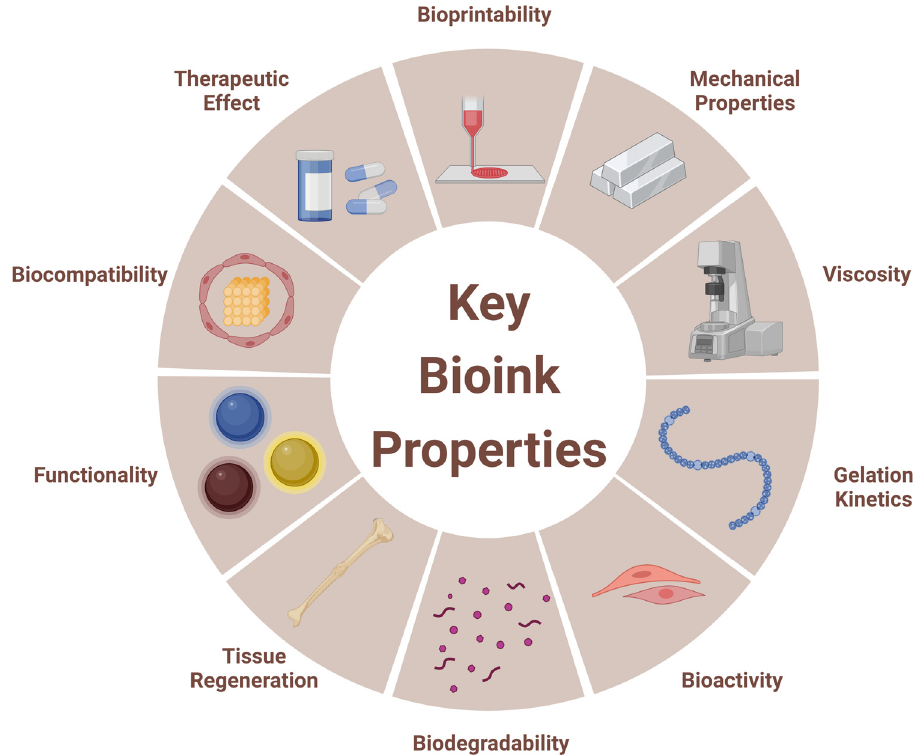
Figure 3: Key properties of the bioink in 3D